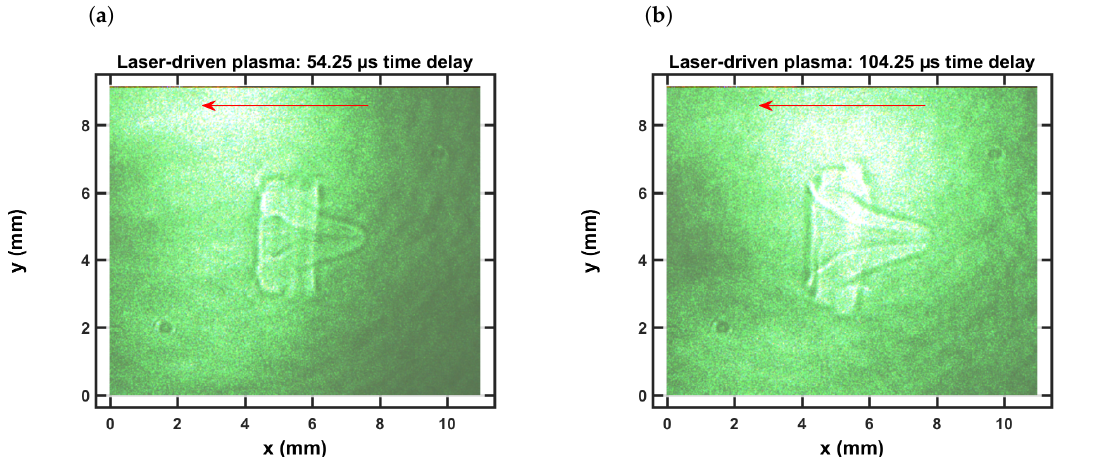
Figure 2. Single-shot shadowgraph of the expanding laser-induced plasma initiated with a 170-mJ, 6-ns, 1064-nm focused beam, and imaged using a 5-ns, 532-nm back-light that is time-delayed by ( a ) 54.25 µ s and ( b ) 104.25 µ